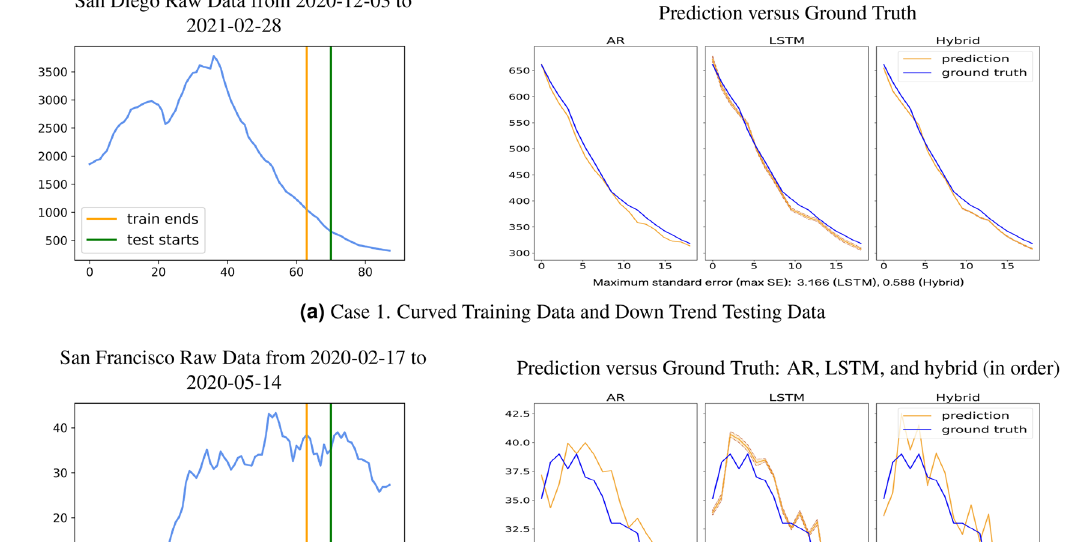
neighboring training points, that are too close to each other, would be attributed more to the instability of model training than to the difference in trend. Such results give us little information about the model performance over